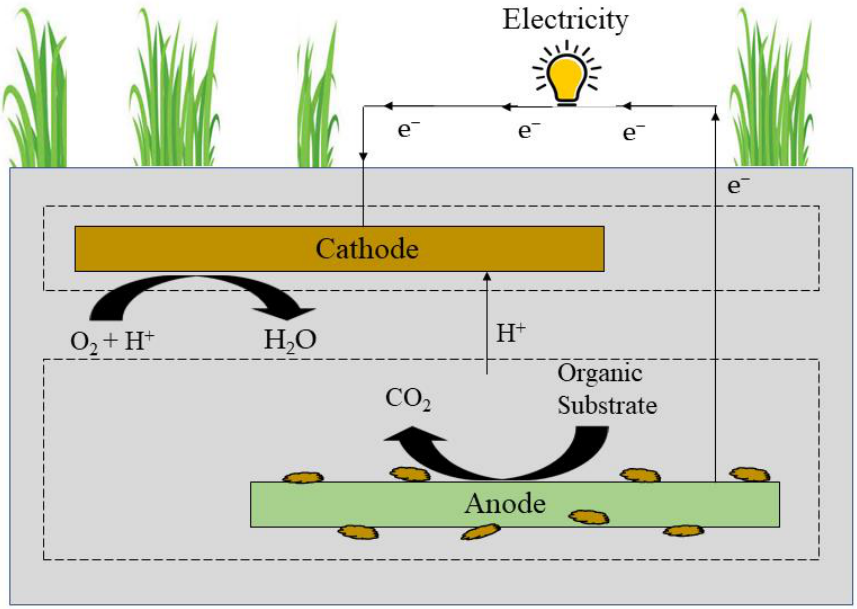
Figure 6. A typical representation of constructed wetland MFCs.